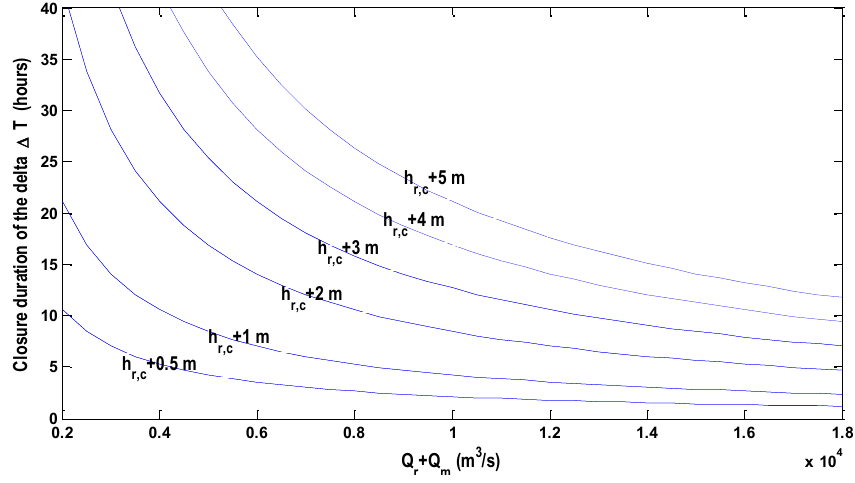
Figure A7. Equal Level Curves with the closable delta at Rotterdam after the delta closes at h r,c .